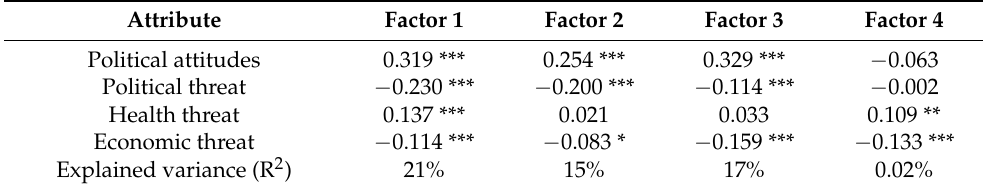
Table 6. Standardized estimates of path analyses of political attitudes and three threats at T3 predicting NR factors at T3 (present from high to low in factor